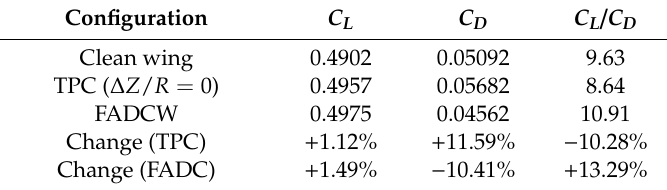
Table 3. Comparisons of C L , C D , and C L / C D at α = 2 ◦ ( Ma = 0.1017, Ω = 4400 r/min, medium grid).